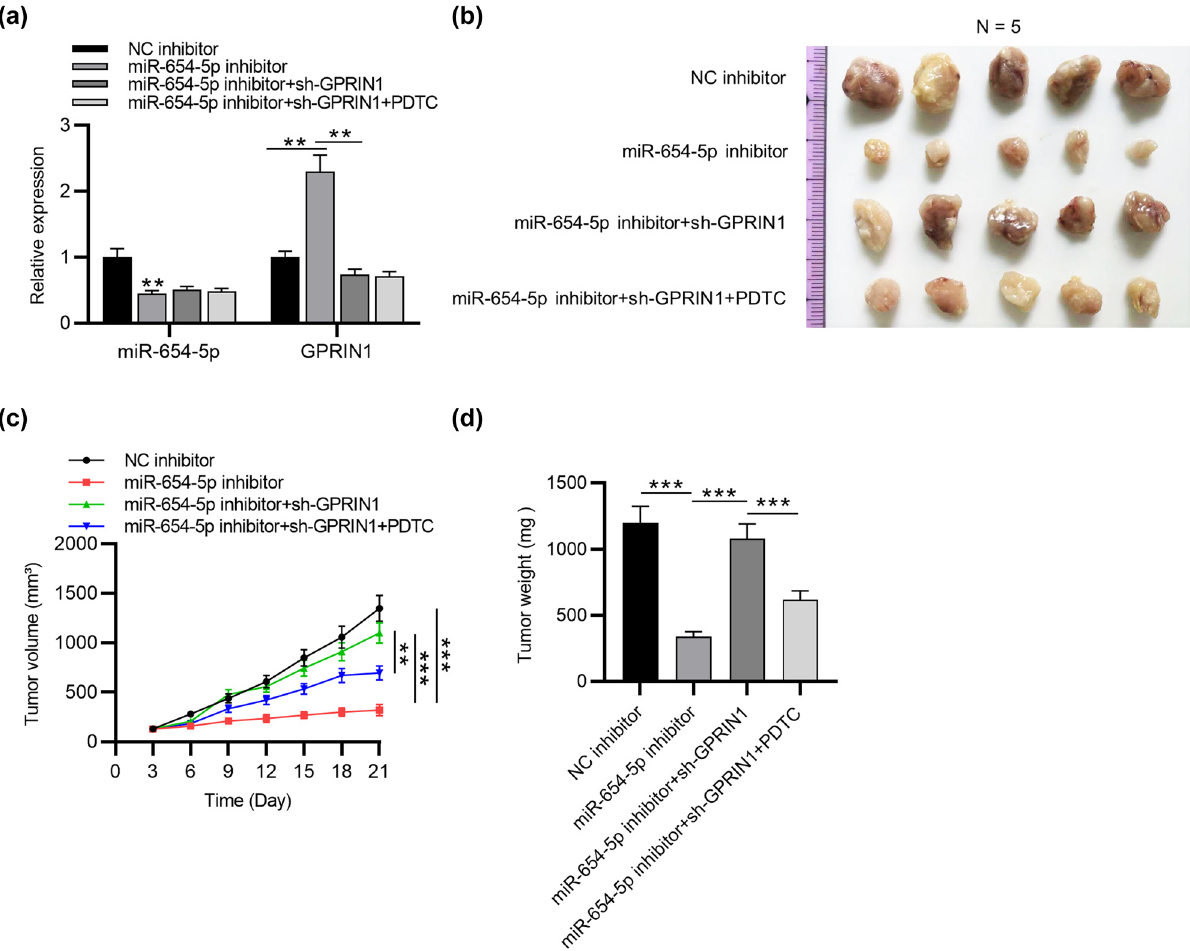
Figure 6: Role of the miR - 654 - 5p/GPRIN1/NF - κ B pathway in a tumor - bearing mouse model. ( a ) Expression of miR - 654 - 5p and GPRIN1 in tumors of mice in the NC inhibitor, miR - 654 - 5p inhibitor, miR - 654 - 5p inhibitor + sh - GPRIN1, and miR - 654 - 5p inhibitor + sh - GPRIN1 + PDTC groups was detected by RT - qPCR. ( b ) Images of tumors. ( c ) Tumor volume was recorded every three days. ( d ) Tumor weight was recorded at the end of the animal experiments. ** p < 0.01, *** p <